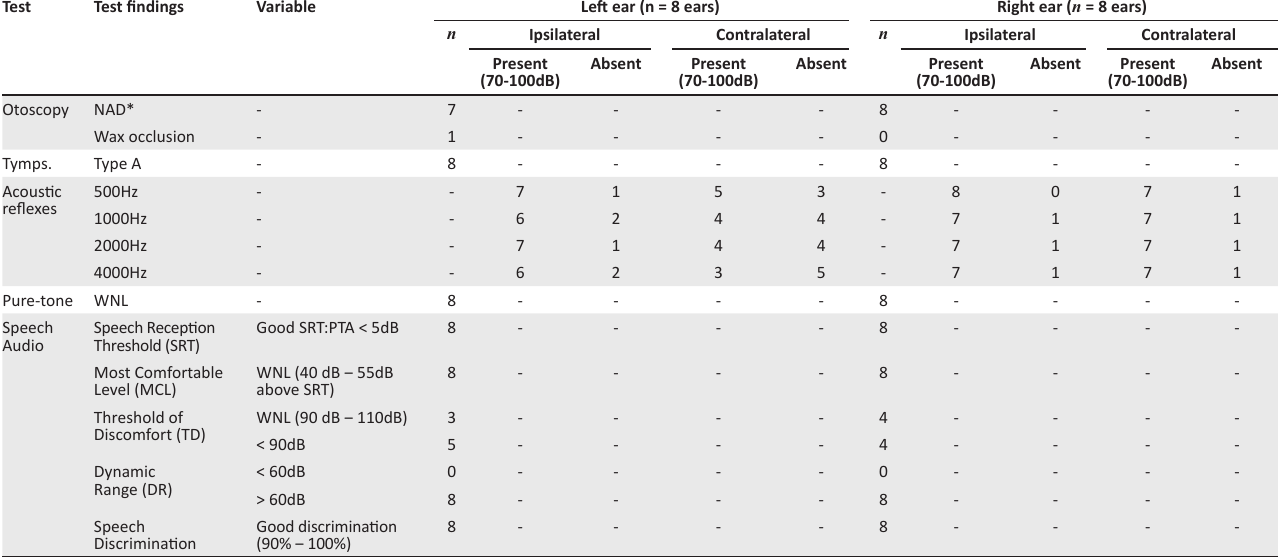
TABLE 4: Results from diagnostic audiological testing ( N = 16 ears) Test Test